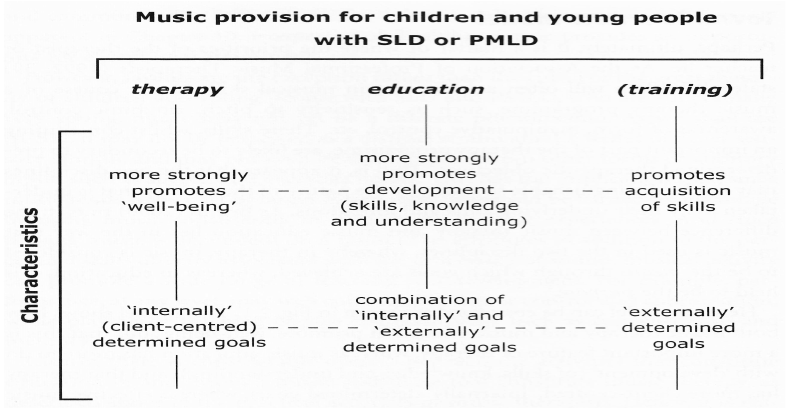
Fig.2.1 The characteristics of music education, therapy (and training) for children and young people with complex needs Fig.2 The characteristics of music education, therapy and training for children and with severe, or profound and multiple learning difficulties.3 Among the ques- tions she asked an equal sample of teachers and therapists working in the field young people with complex needs. From Ockelford (2008: 42) 10 (N : 96) was'To what extent does the child play a part in guiding your ses- sions/lessons? The permitted range of responses was from ' 1 : not at all' to '10 - completely'set out on a Likert scale. The results are shown in Fig. 2.2. These suggest that, as populations, teachers and therapists do indeed differ in the